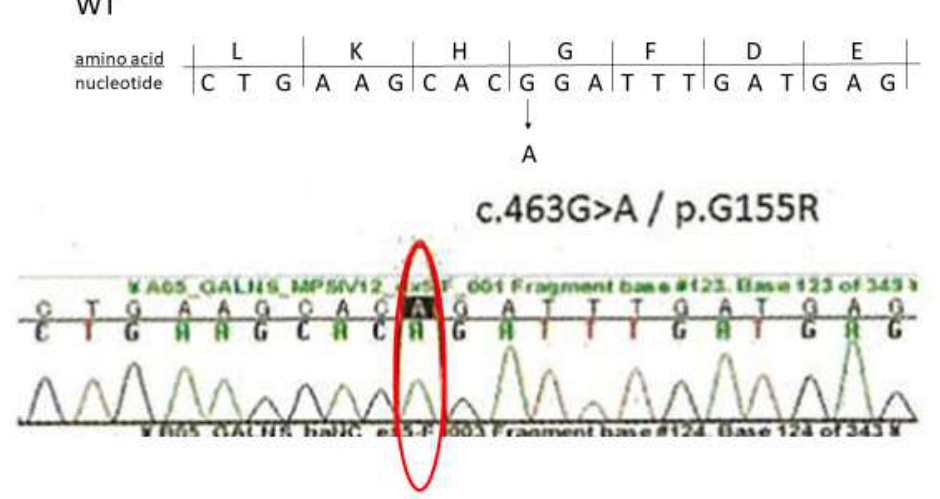
Figure 3. The genetic analysis of the GALNS gene in a Japanese boy with MPS IVA. Sanger sequencing of GALNS detected a homozygous variant c.463G > A (p.Gly155Arg).